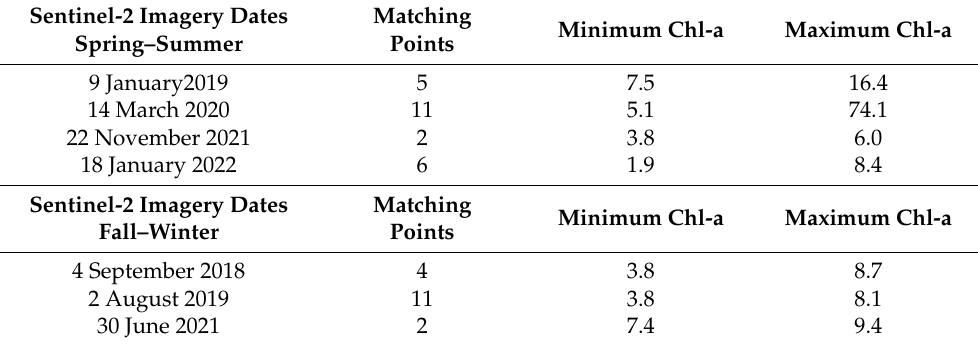
Table 2. Dates of the Sentinel-2 images used in this study, chlorophyll-a ranges in µ g L − 1 and the number of matching